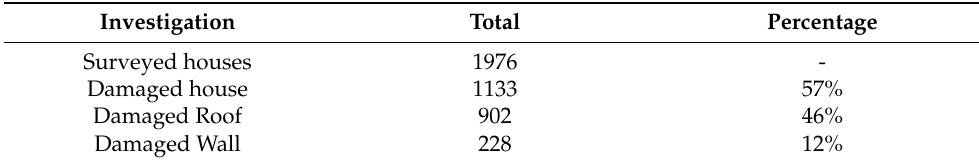
Table 1. Statistics of field investigation after typhoon Faxai in